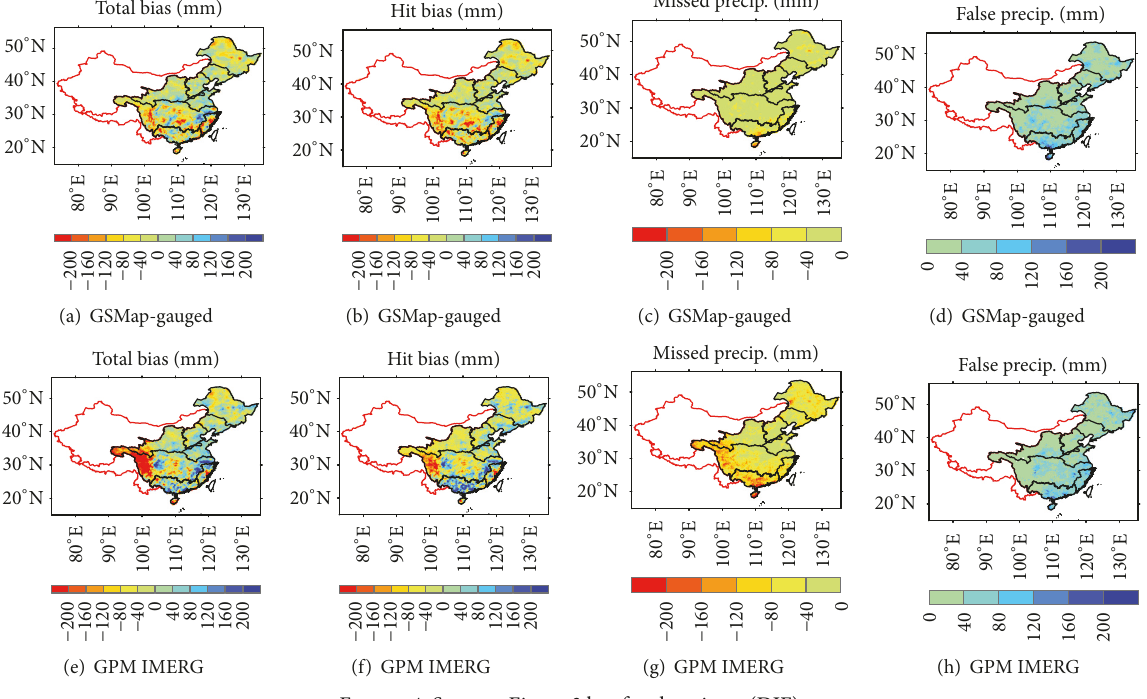
Figure 4: Same as Figure 3 but for the winter (DJF).